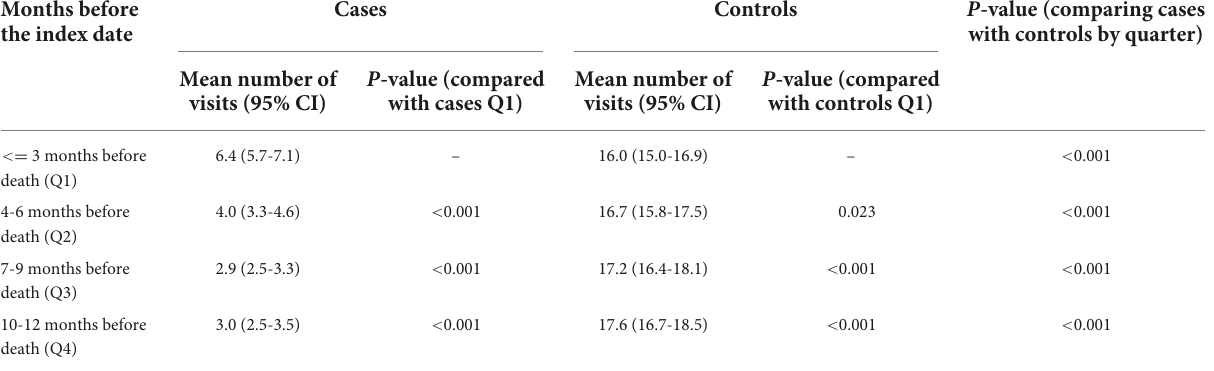
TABLE 4 Mean number of visits per quarter before the index date for cases and